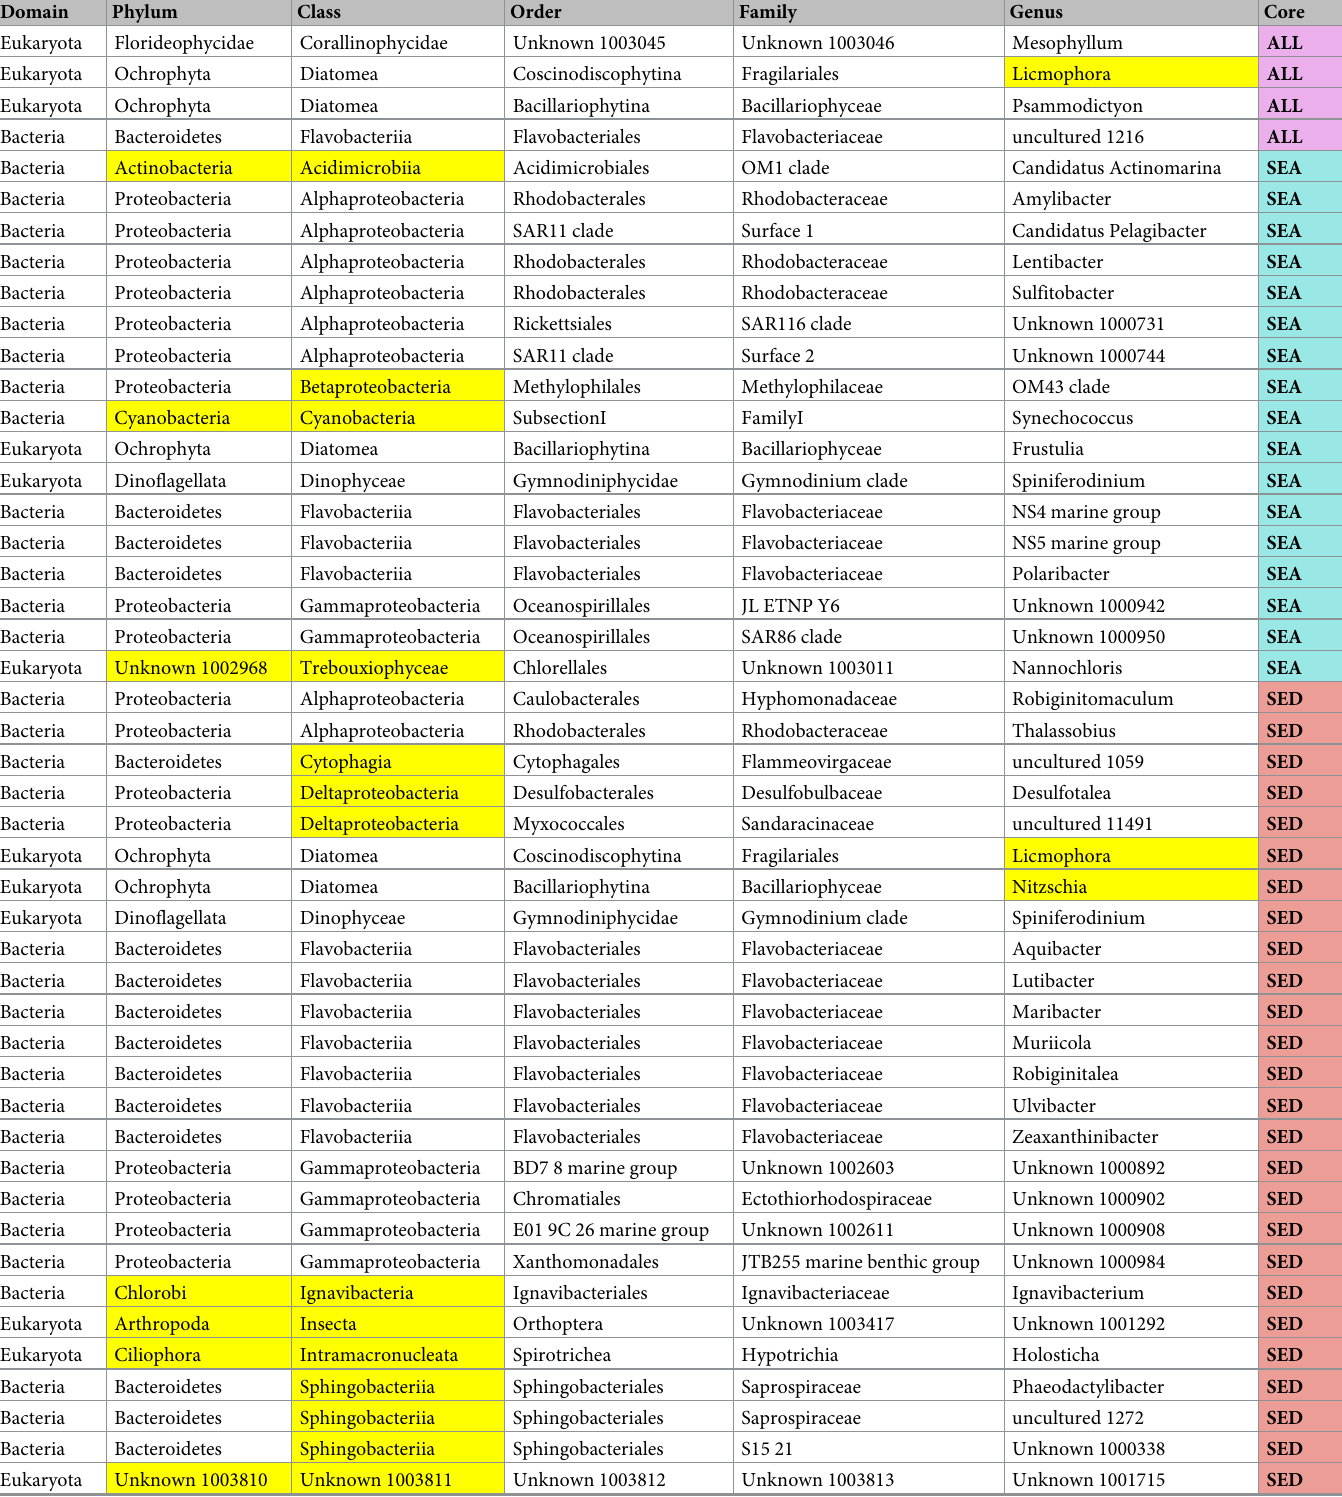
Table 1. Shared (core) and unique core taxa for environment type and